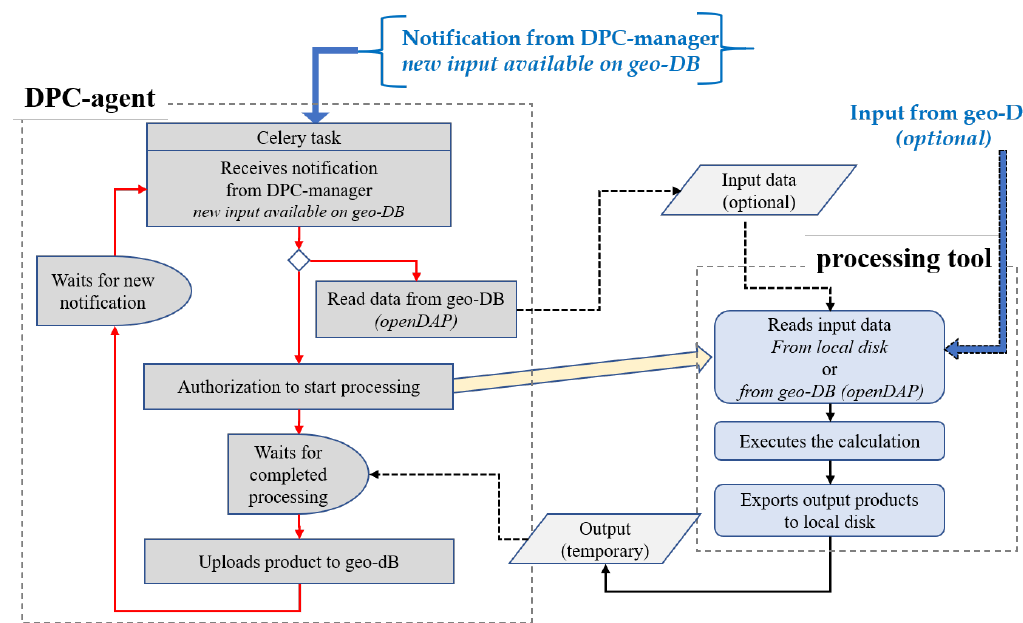
Figure 6. Schematic flowchart representation of the integration of a processing module in the technological